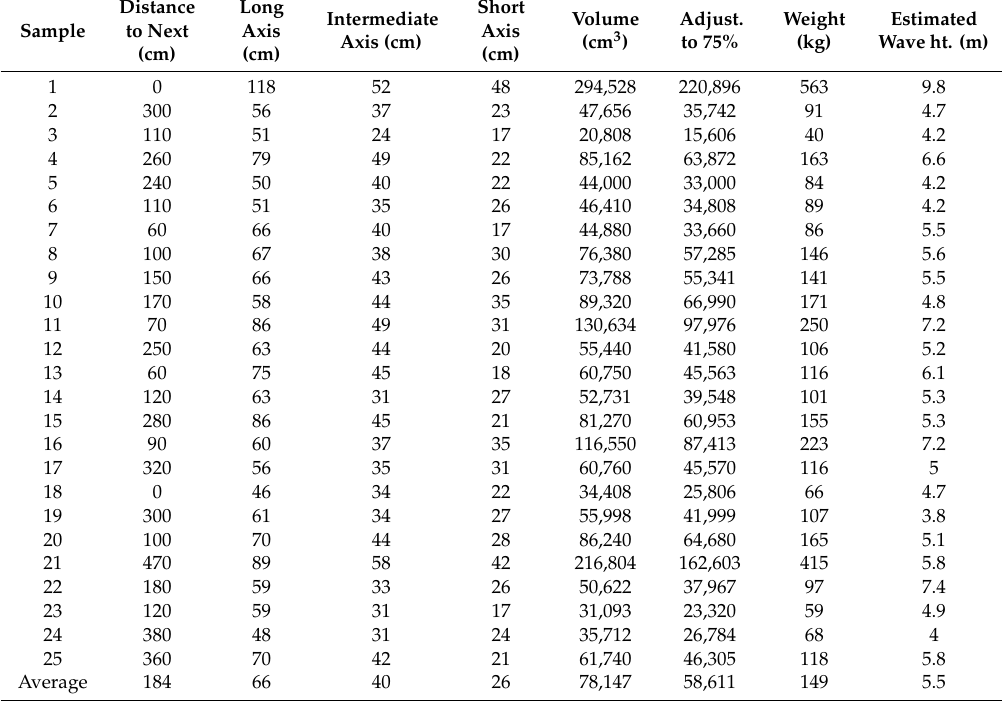
Table 6. Quantification of boulder size, volume and estimated weight from coastal bar samples from transect 2b. (north of Cerro Enfernmera). The laboratory result for density at 2.55 gm / cm 3 is applied uniformly in order to calculate wave height for each